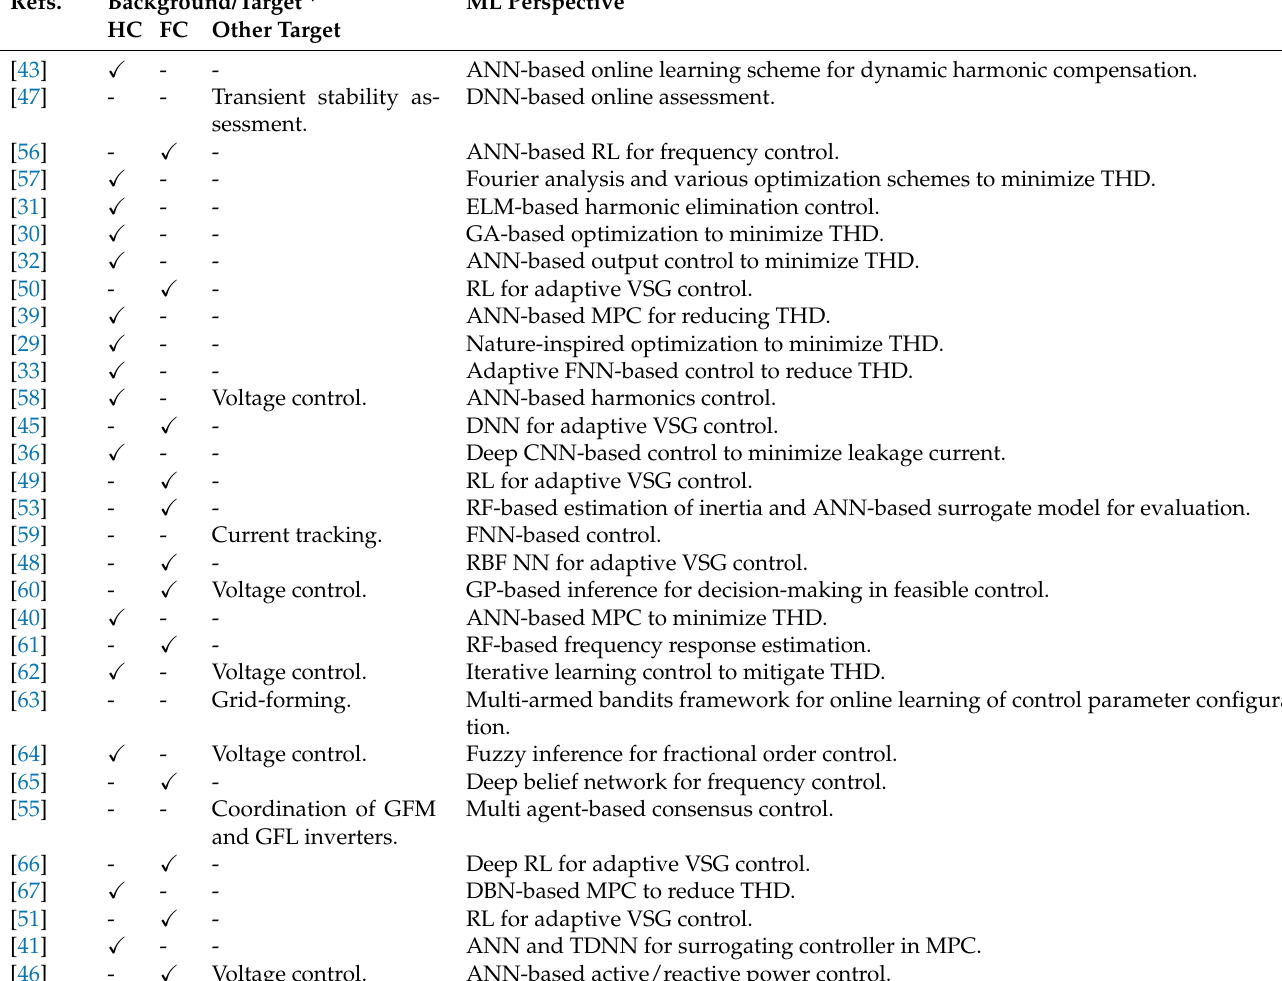
Table 3. Relevant studies on ML-based wide-area grid support. Refs.